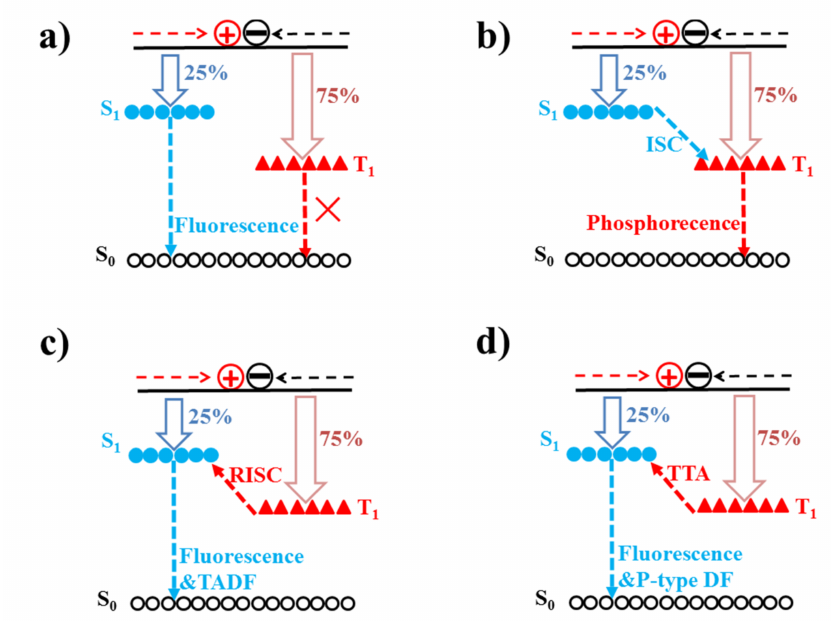
Figure 1. Exciton energy diagram and the possible decay ways of singlet and triplet excitons. Emissions from conventional fluorescent emitters ( a ); phosphorescent emitters ( b ); TADF emitters( c ) and TTA based emitters ( d ). Reproduced with permission from